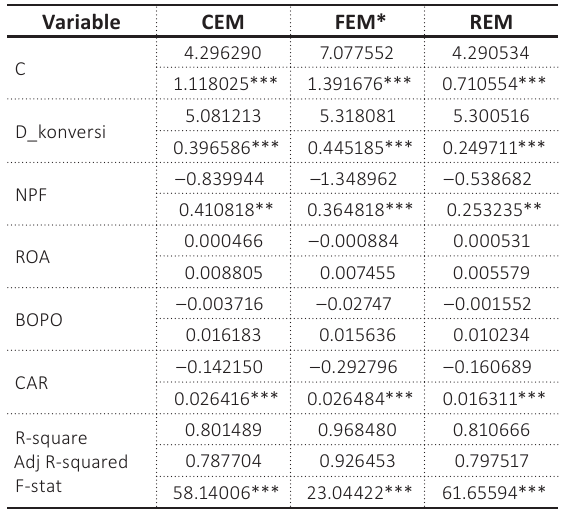
Table 1. Empirical result impact of conversion on market share